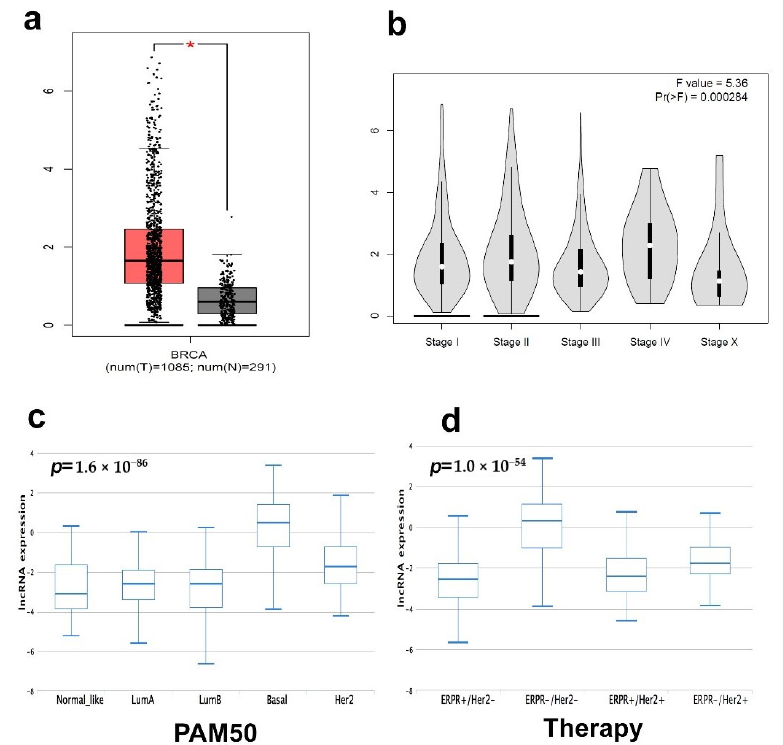
Figure 6. Expression of LINC00511 and its correlation with pathological stage in BC. ( a ) Expression of LINC00511 in BC (n = 1085) compared to normal breast tissue (n = 291) from the BRCA TCGA cohort. ( b ) Stage plot demonstrating LINC00511 expression as a function of pathological stage in the BRCA TCGA breast cancer cohort (n = 1085). Expression on LINC00511 as a function of PAM50 classification ( c ) or as a function of therapy ( d ) based on the TANRIC database. * p <